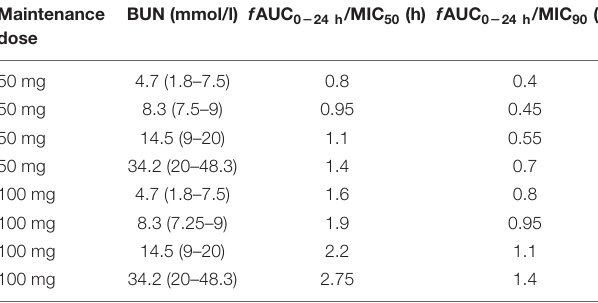
TABLE 5 | AUC/MIC simulation of TGC in different range of